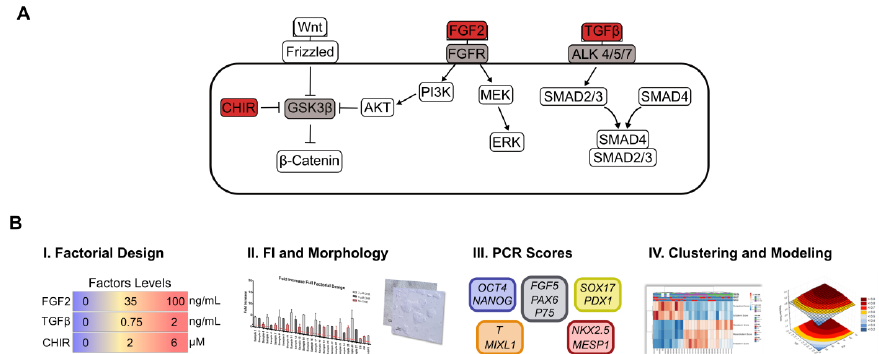
Figure 1. Schematic representation of the experimental framework used in this study. ( A ) A